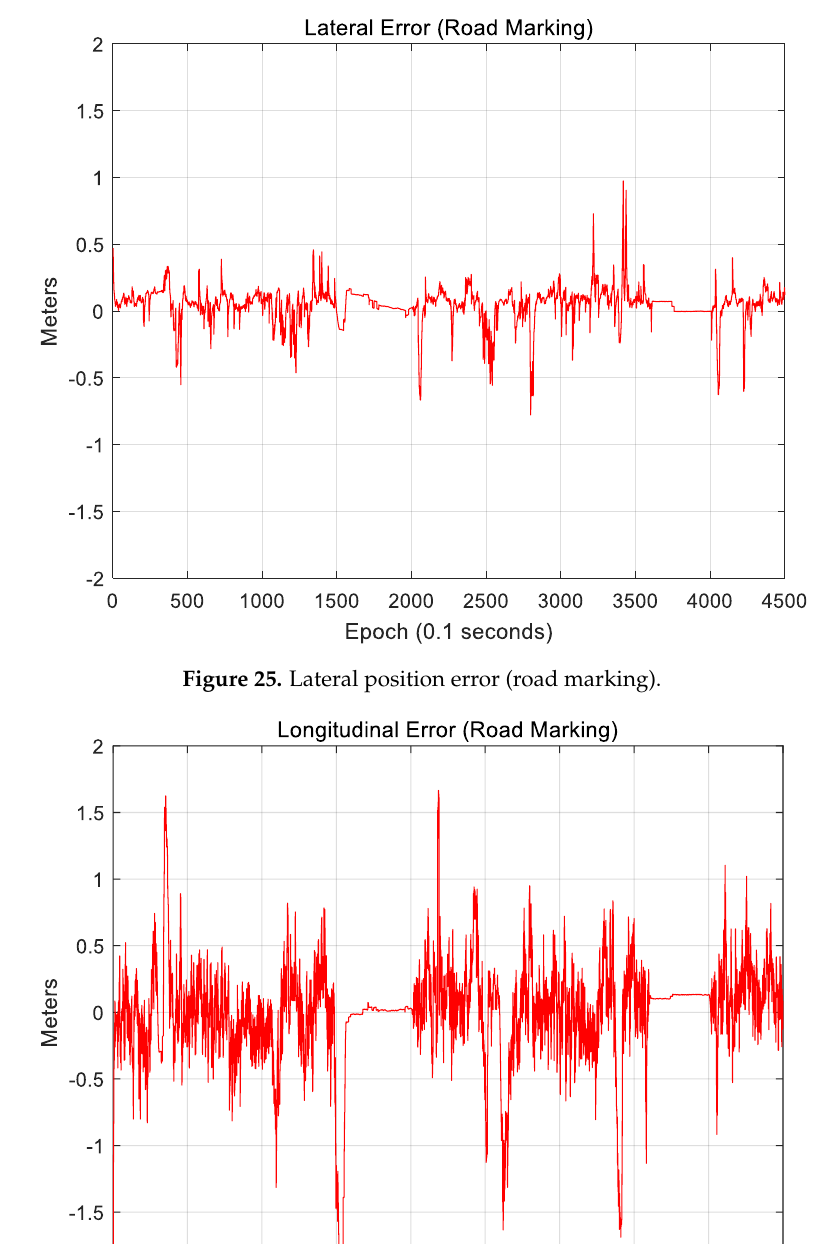
Figure 27. Lateral position error (vertical structure).